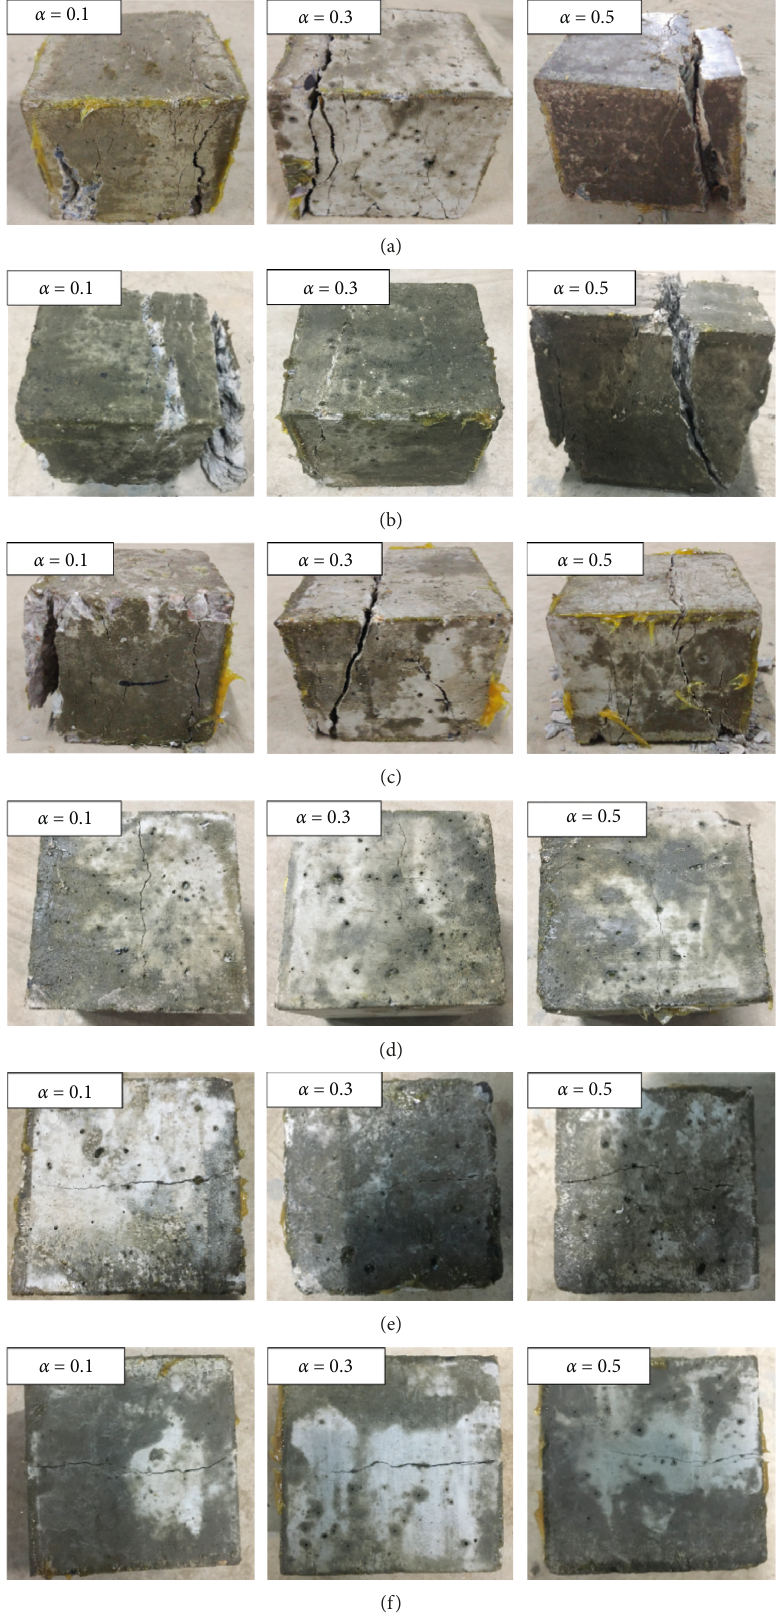
Figure 3: Biaxial loading failure mode. Biaxial compression-compression: (a) C30; (b) C40; (c) C50. Biaxial compression-tension: (d) C30; (e) C40; (f)